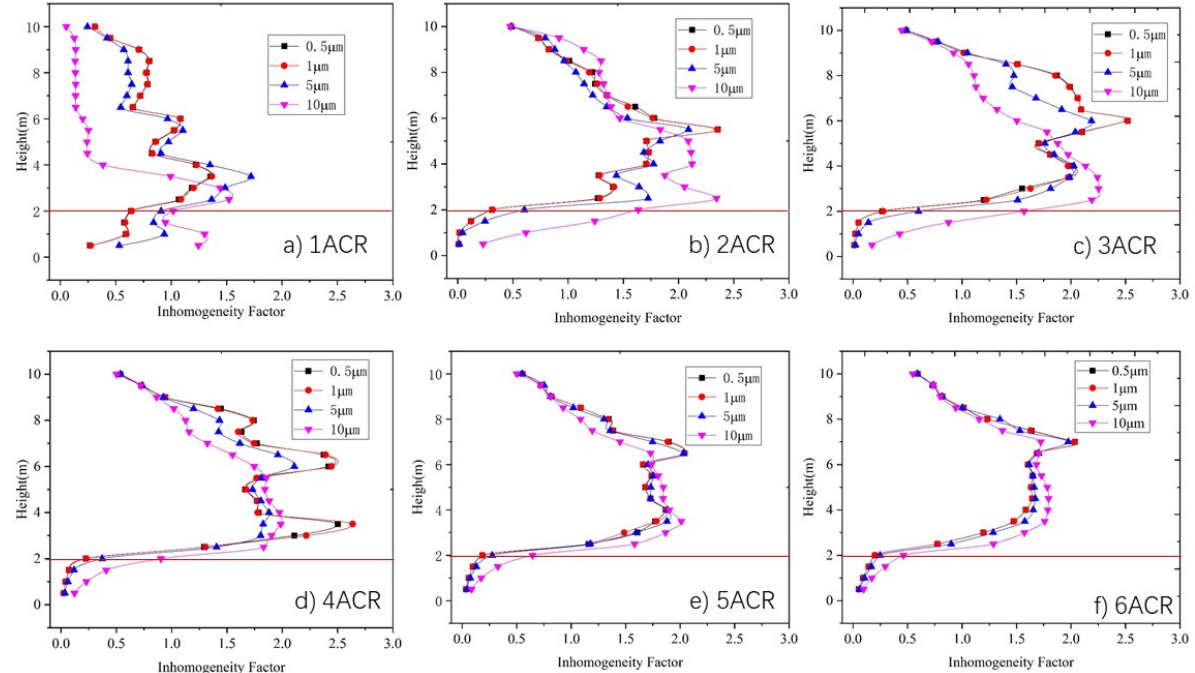
Figure 9. Relationship between vertical average inhomogeneity factor for particles of various sizes under different air change rate: ( a ) ACR = 1, ( b ) ACR = 2, ( c ) ACR = 3, ( d ) ACR = 4, ( e ) ACR = 5, ( f ) ACR = 6.